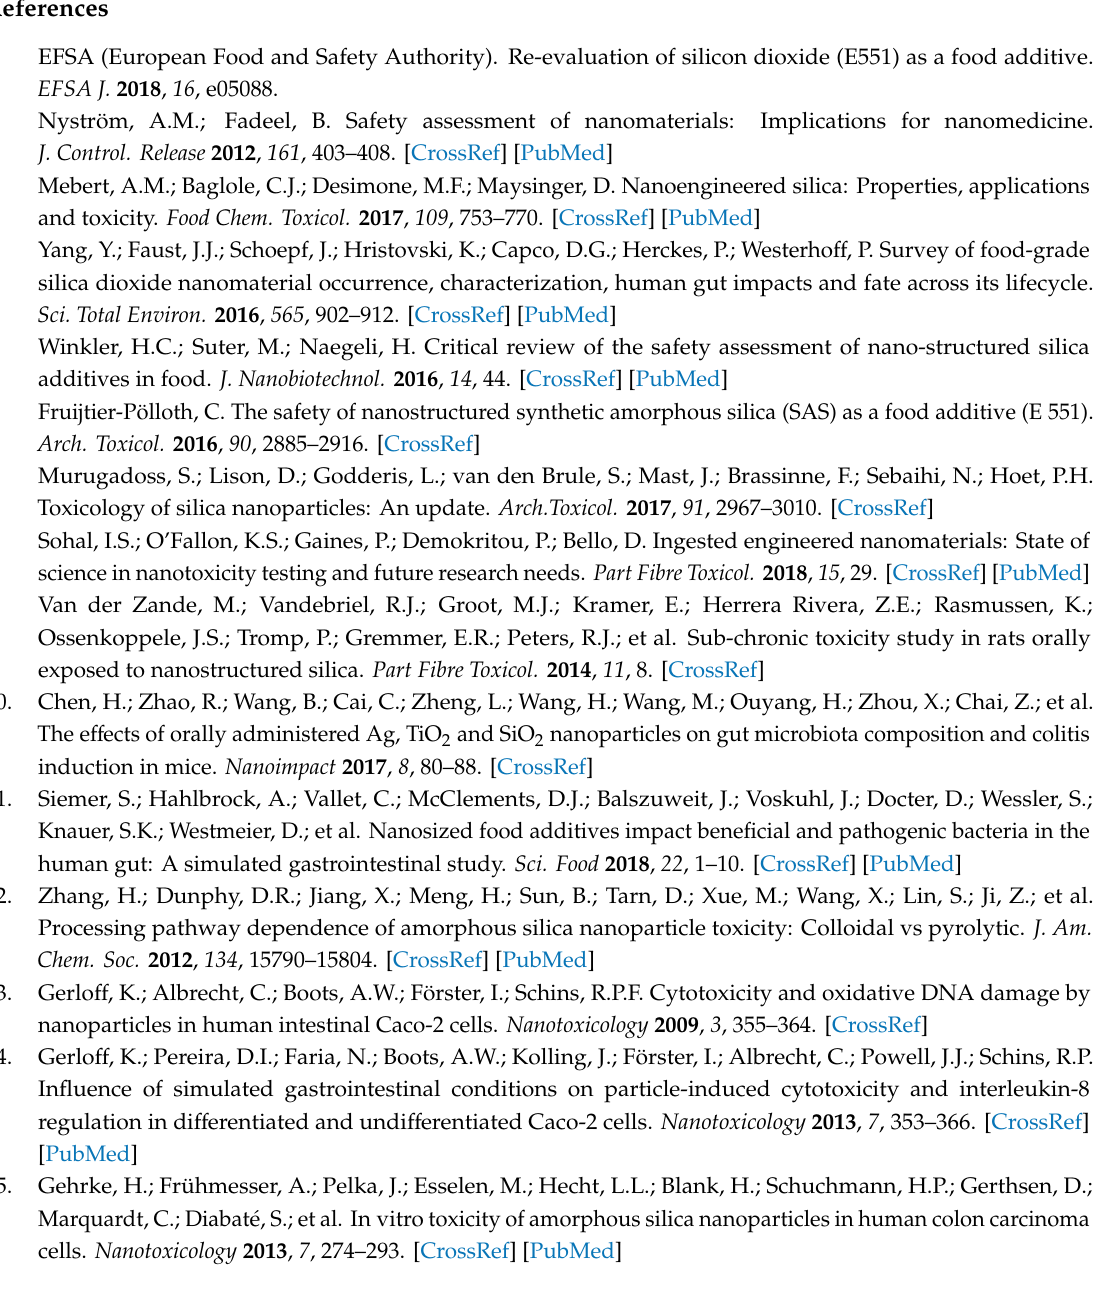
modification. Figure S8: Cell viability decreases after incubation of HCT p53 − / − cells with SiO 2 —12 nm NPs for 24 h in the absence of FBS. Figure S9: HCT116 p53 − / − cells are more sensitive to SiO 2 —12 nm NPs than HCT116 wt cells. Figure S10: Low amount of serum (1% FBS) reduces membrane damage provoked by SiO 2 —12 nm NPs. Figure S11: The response of HCT116 wt and p53 − / − cells to SiO 2 —12 nm NP exposure after 48 h is similar. Figure S12: Summary of the results from the di ff erent toxicity assays to demonstrate the similar sensitivity of HCT wt and p53 − / − cells to SiO 2 —12 nm NPs dependent on the concentration of FBS. Video S1: Time course of cell death after incubation to SiO 2 —12 nm NPs in the absence of